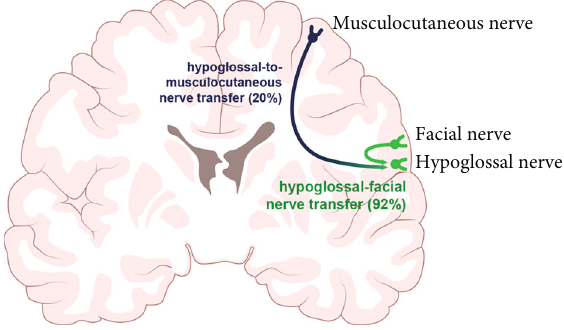
Figure 3: Neuroplasticity responsible for unfavorable clinical results after a hypoglossal-to-musculocutaneous nerve transfer. The distance between the tongue cortical area (hypoglossal nerve) and the arm representation (musculocutaneous nerve) is greater than that between the tongue cortical area (hypoglossal nerve) and the musculus facialis representation (facial nerve). This distance obscures the formation of the new connection to generate the cortical